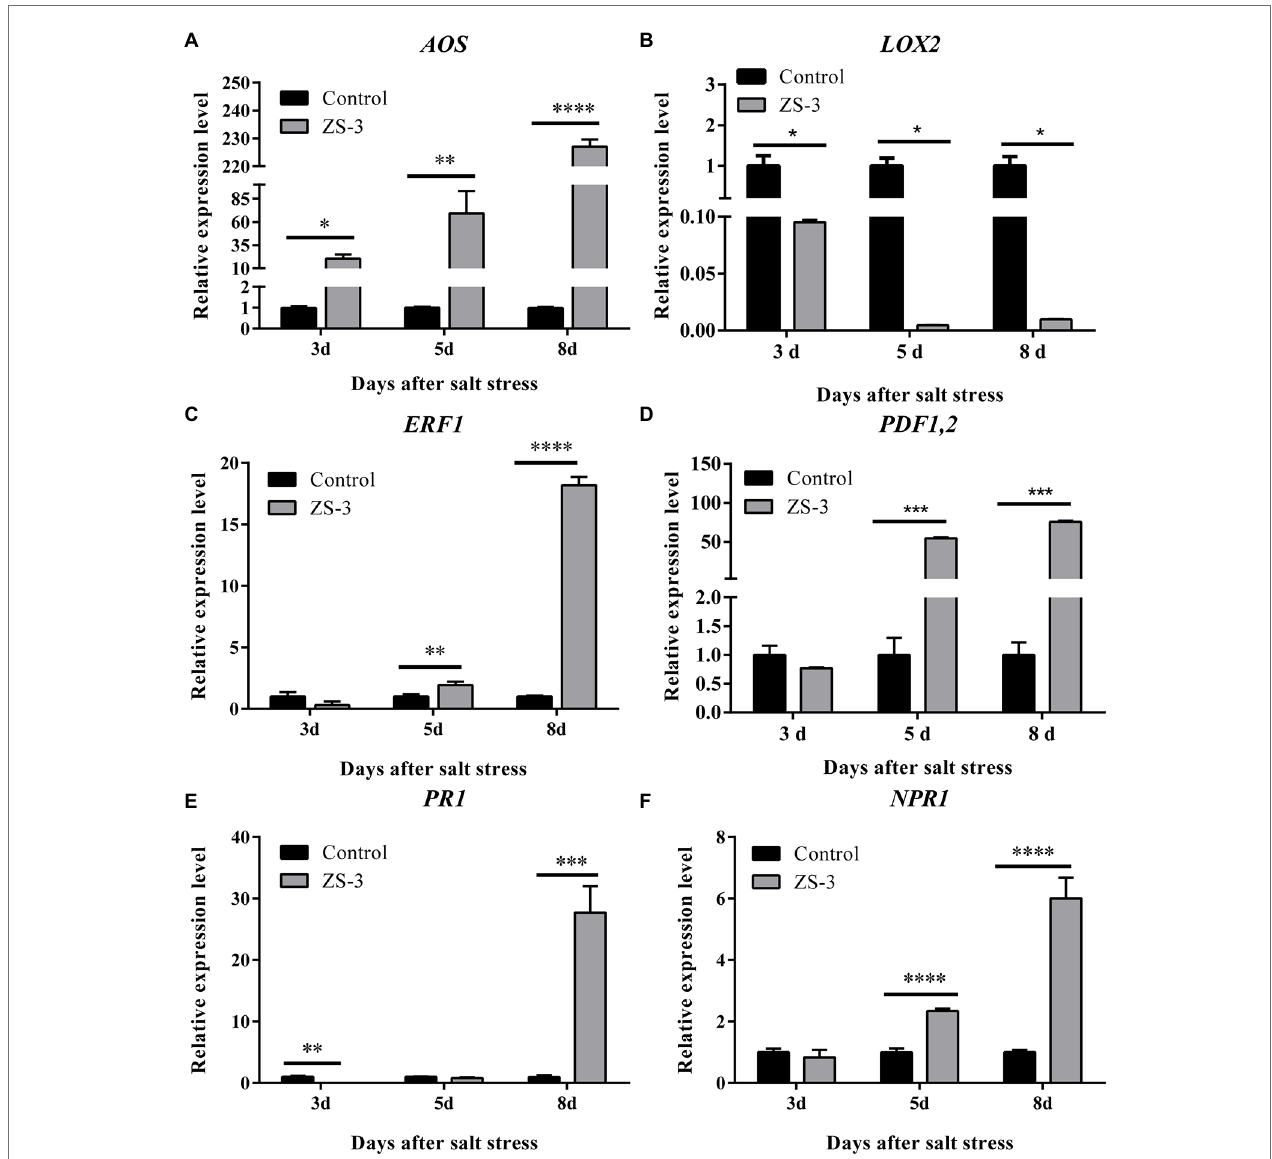
FIGURE 6 | Real-time polymerase chain reaction (PCR) analysis of gene expression under salt stress. The expression levels of the Arabidopsis thaliana defense- related genes AOS (A) , LOX2 (B) , ERF1 (C) , PDF1.2 (D) , PR1 (E) , and NPR1 (F) were quantified by qRT–PCR at days 3, 5 and 8 after inoculation with strain ZS-3. Arabidopsis thaliana inoculated with inactivated bacterial dilutions was used as a control. The results are the mean ± standard deviation of three independent experiments. Asterisks on the bars indicate significant differences between treatments based on t -test analysis (* p < 0.05; ** p < 0.01; *** p < 0.001; **** p <